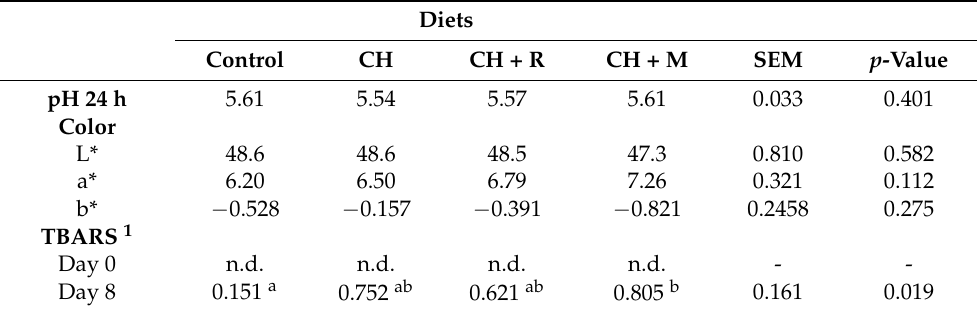
Table 3. Effect of experimental diets on pH 24 h, CIE color parameters (L*, a*, b*) and TBARS levels (mg malondialdehyde/kg muscle) after 0 and 8 days under refrigeration in longissimus lumborum